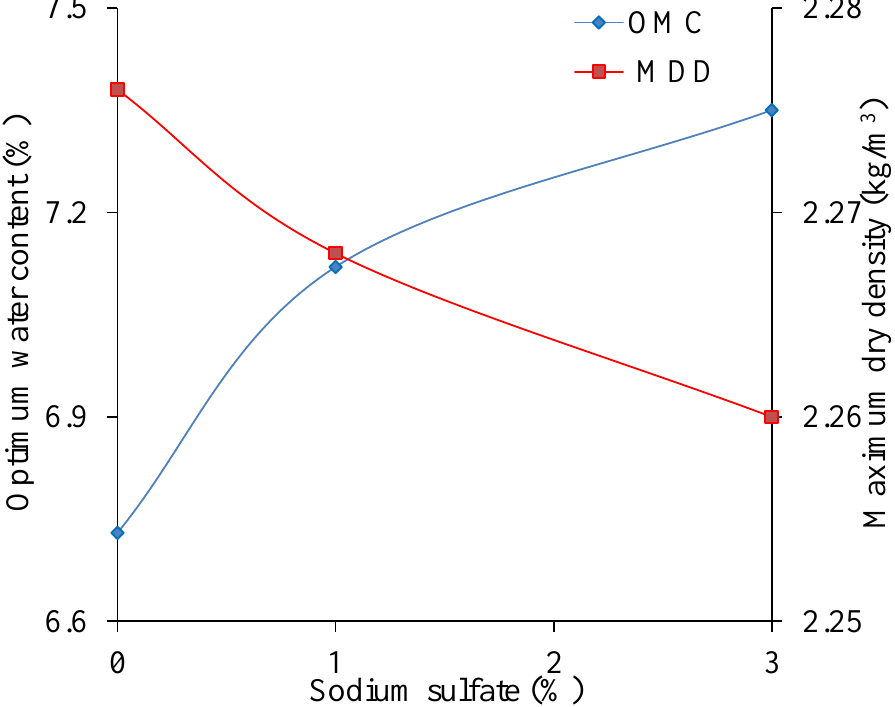
Figure 12. The influence of the sodium sulfate content on the compaction results.